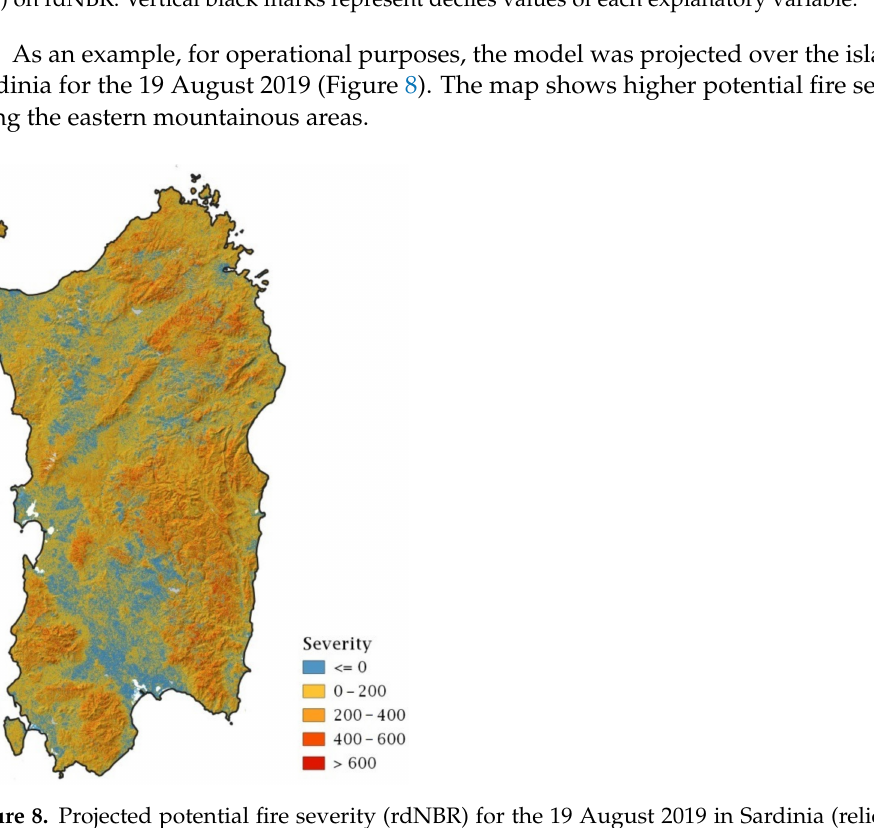
Figure 8. Projected potential fire severity (rdNBR) for the 19 August 2019 in Sardinia (relief data also